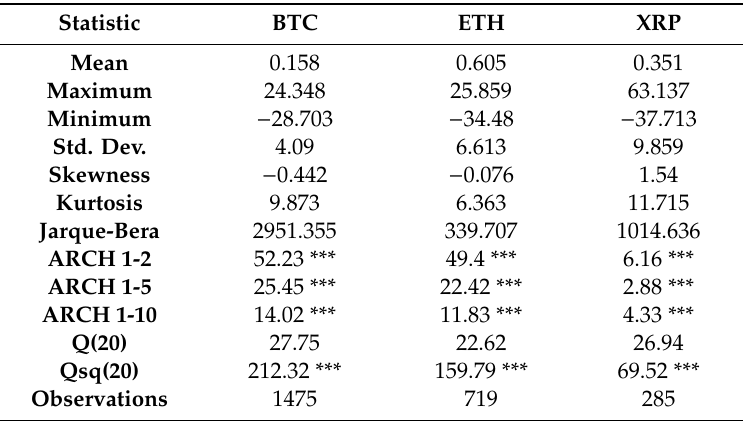
Table 1. Descriptive